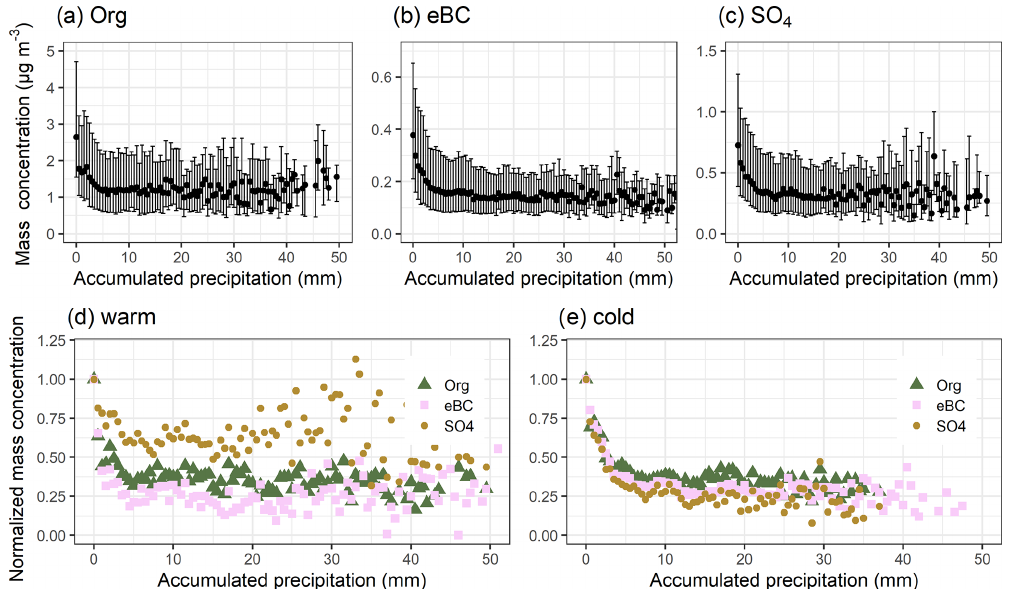
Figure 4. Particle mass concentration of (a) Org, (b) eBC, and (c) SO 4 as a function of accumulated precipitation along the 96h HYSPLIT air mass trajectories from all seasons. The black dots in the top row show the median values, and bars highlight the 25th–75th percentiles for each 0.5mm bin of accumulated precipitation. Panels (d) and (e) show normalised particle masses (calculated from the medians) with temperature separation. Medians and normalised medians are shown for each bin having 10 or more data points. The figure includes data between 2006–2019 for eBC and 2012–2019 for Org and SO 4